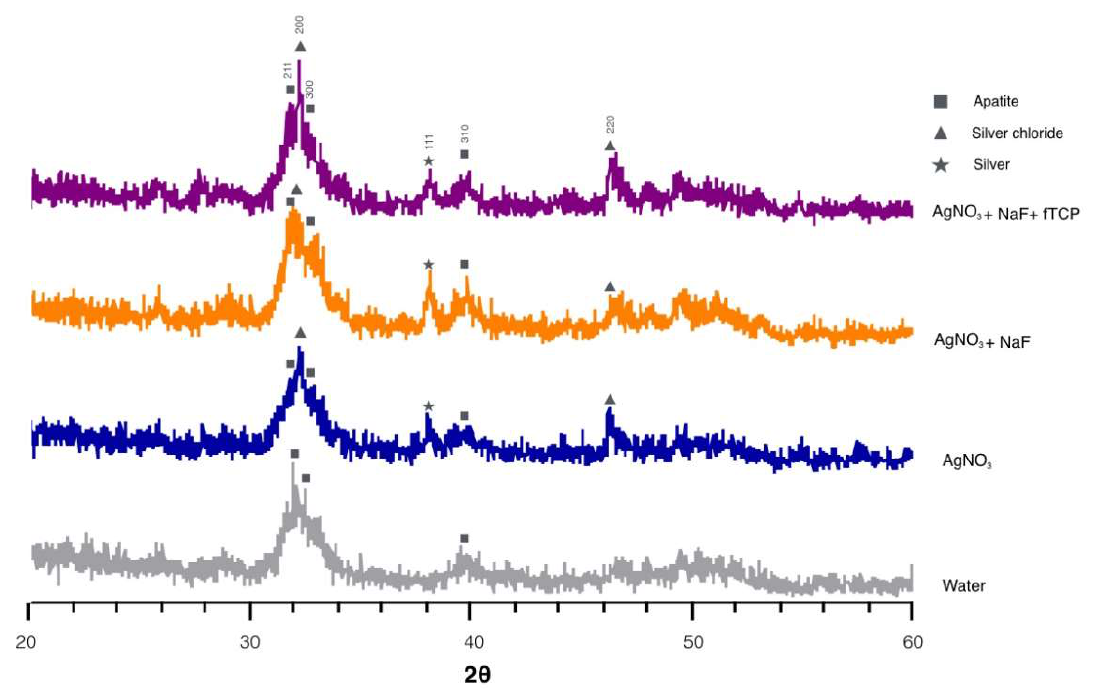
Figure 2. Typical X-ray diffraction patterns of the dentine in the four treatment groups.